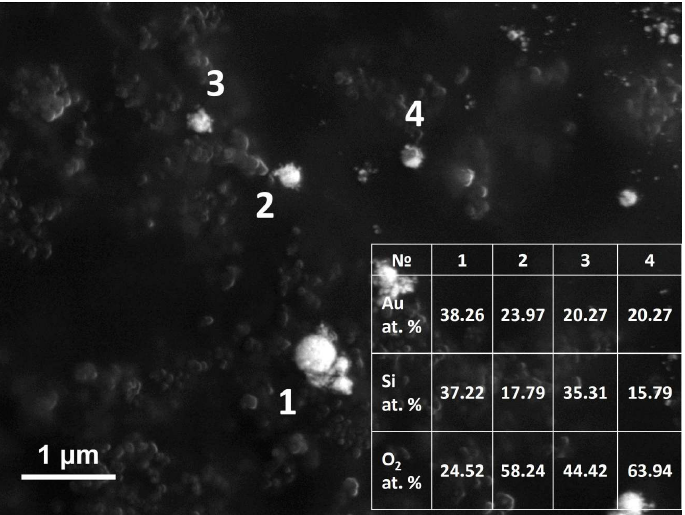
Figure 3. High-angle annular dark field (HAADF) SEM image of hybrid NPs obtained from 30/180 nm Au/Si film and transferred to carbon tape. Legend shows corresponding contents of gold and silicon in atomic percents found by EDX at positions marked by numbers 1–4.